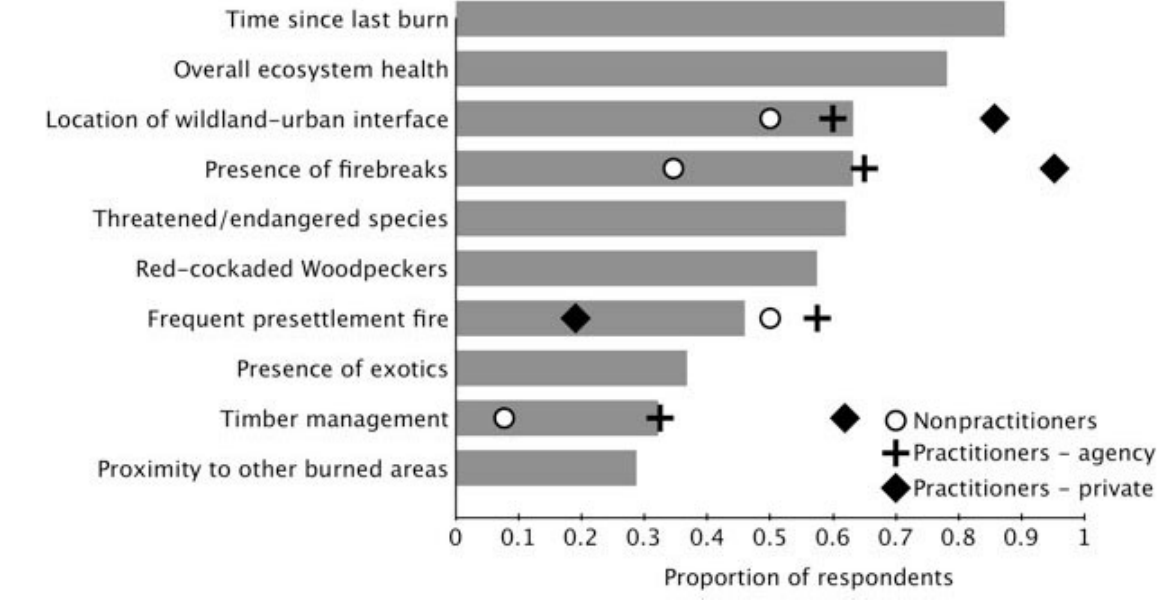
Fig. 3. Proportion of survey respondents who indicated each criterion is important for determining burn priorities. Bars represent proportions of the overall survey population, while circles, crosses, and diamonds are only shown for criteria that show significant differences among stakeholder